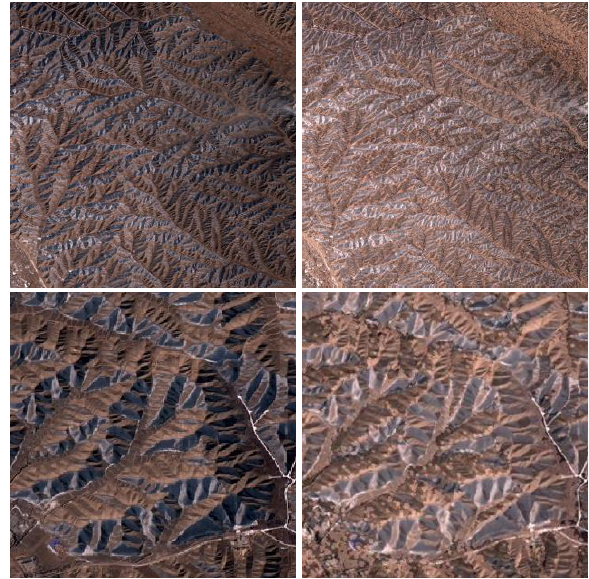
Figure 7. Shadow detection results detail